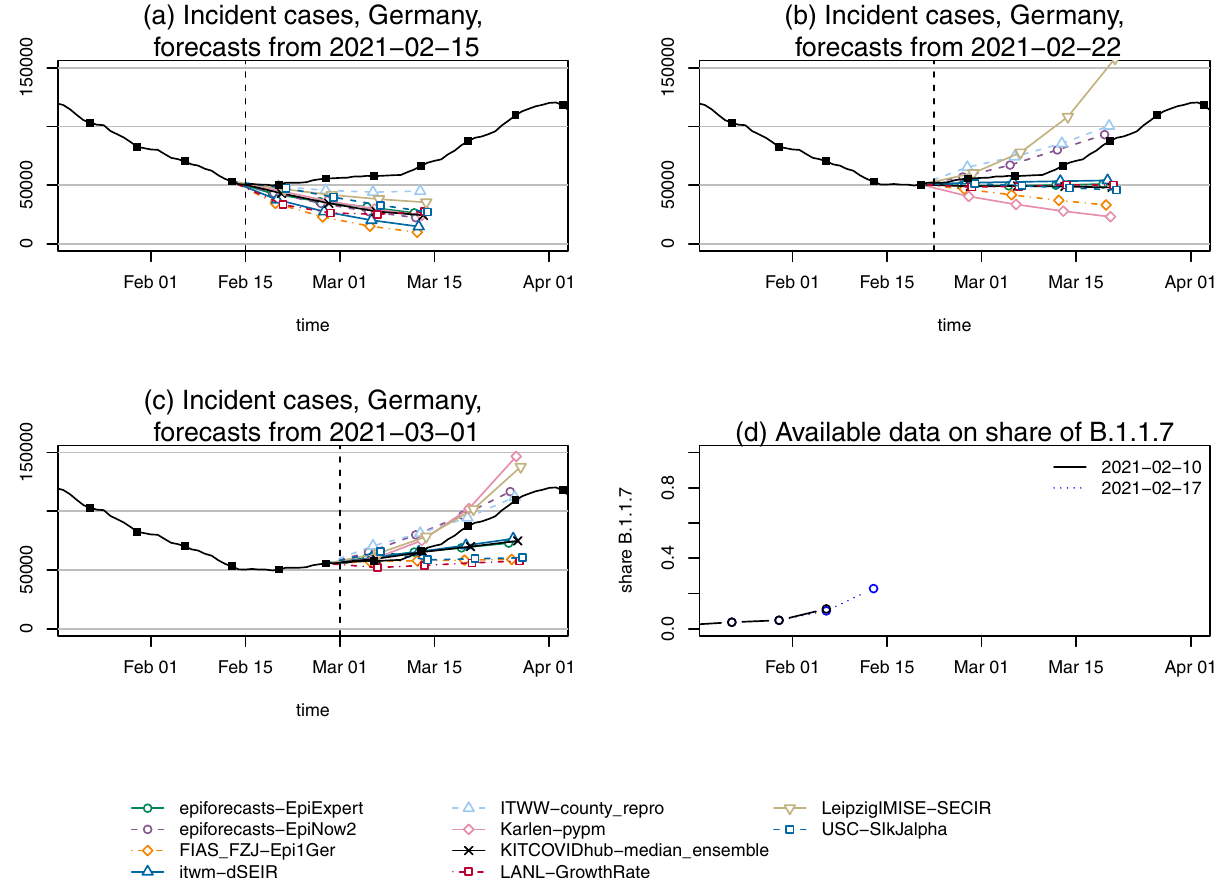
Fig. 5 Case forecasts in Germany preceding the upward trend change in March 2022. Point forecasts of cases in Germany, as issued on a 15 February, b 22 February, and c 1 March 2021. These dates, shown as vertical dashed lines, mark the start of a renewed increase in overall case counts due to the new variant of concern B.1.1.7. d Data by RKI on the share of the B.1.1.7 variant as available on the different forecast dates (the next data release by RKI occurred on 3 March). The models Karlen-pypm and LeipzigIMISE-SECIR accounted for the presence of multiple variants from 1 March